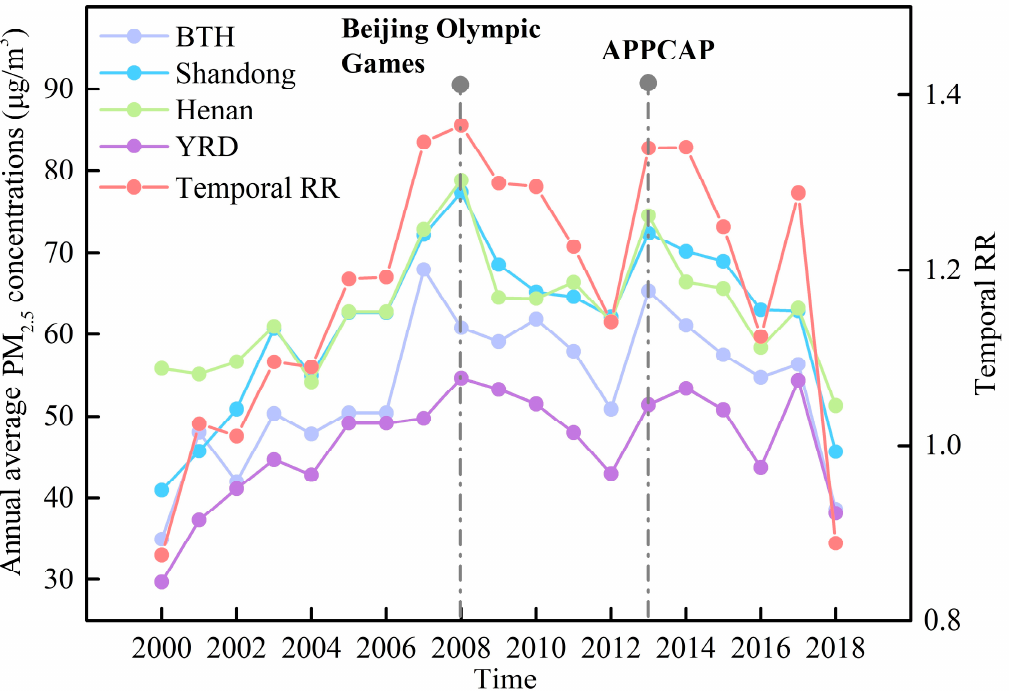
Figure 3. Temporal relative risks and variations in PM 2.5 concentrations in different regions. Note: BTH is Beijing–Tianjin–Hebei region; YRD is Yangtze River Delta region; RR is relative risks; APPCAP is the Air Pollution Prevention and Control Action Plan.